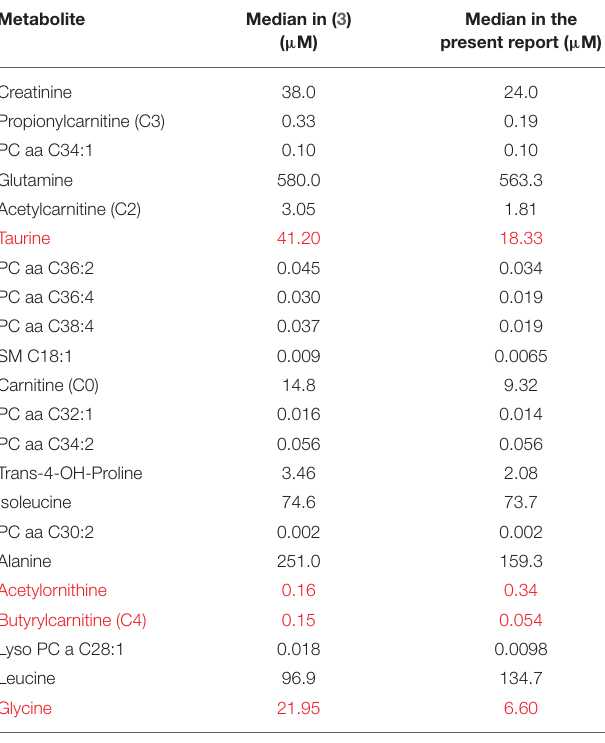
TABLE 2 | Values of sensitivity, specificity and area under the curve obtained from TABLE 1 | Comparison of concentration of metabolites (median) in controls with the ROC plots in Figure 2 . those in the Buisset et al. (3) report. Metabolite Median in (3) Median in the Metabolite Sensitivity ( µ M) present report ( µ M)